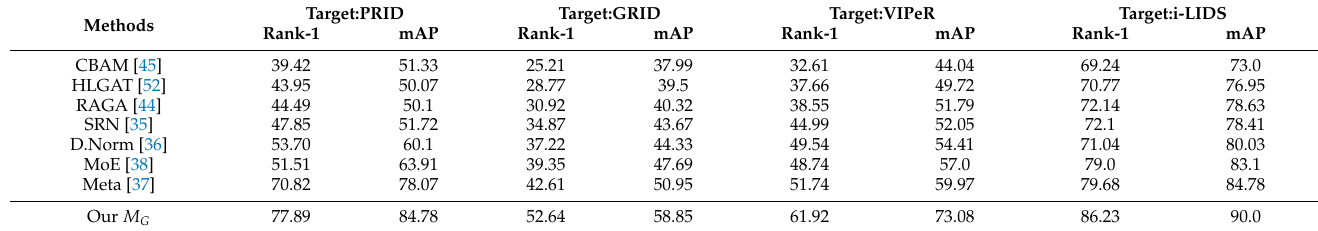
Table 3. Results on Naïve Close-Set Setting#2.